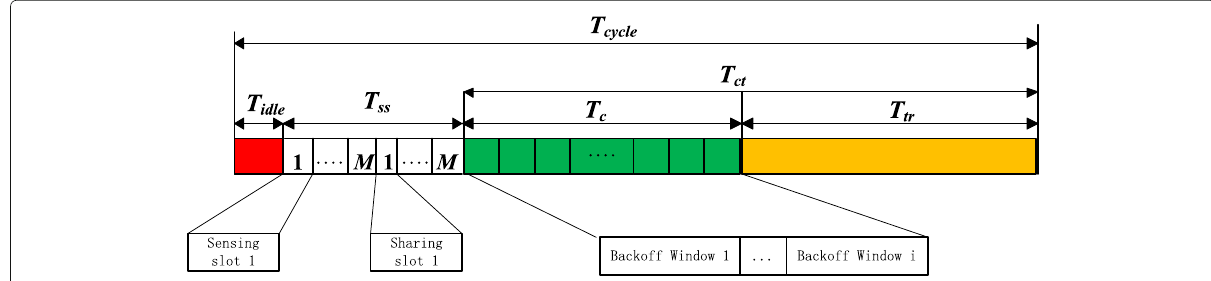
Fig. 2 Frame structure of the proposed MAC protocol. To show the frame structure of the proposed MAC